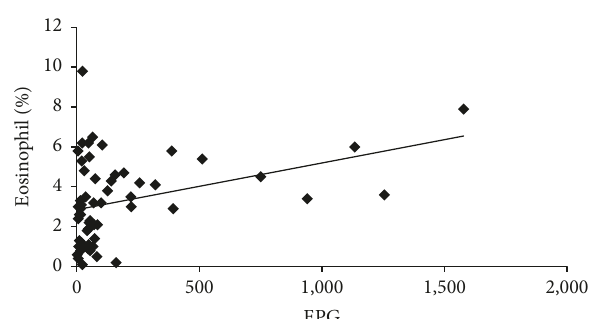
Figure 2: Relationship between parasite quantity (EPG) and eosinophil count in C. sinensis infected patients. Pearson correlation analysis shows a significant positive correlation in C. sinensis infected patients between the eggs per gram (EPG) in their stool and their eosinophil counts (Pearson’s 𝑟 = 0.36 , 𝑝 = 0.014 , and 𝑛 = 57 ). The results of linear regression analysis are shown (line slope is 𝑦 = 0.002𝑥 + 2.855 and 𝑟 2 = 0.13